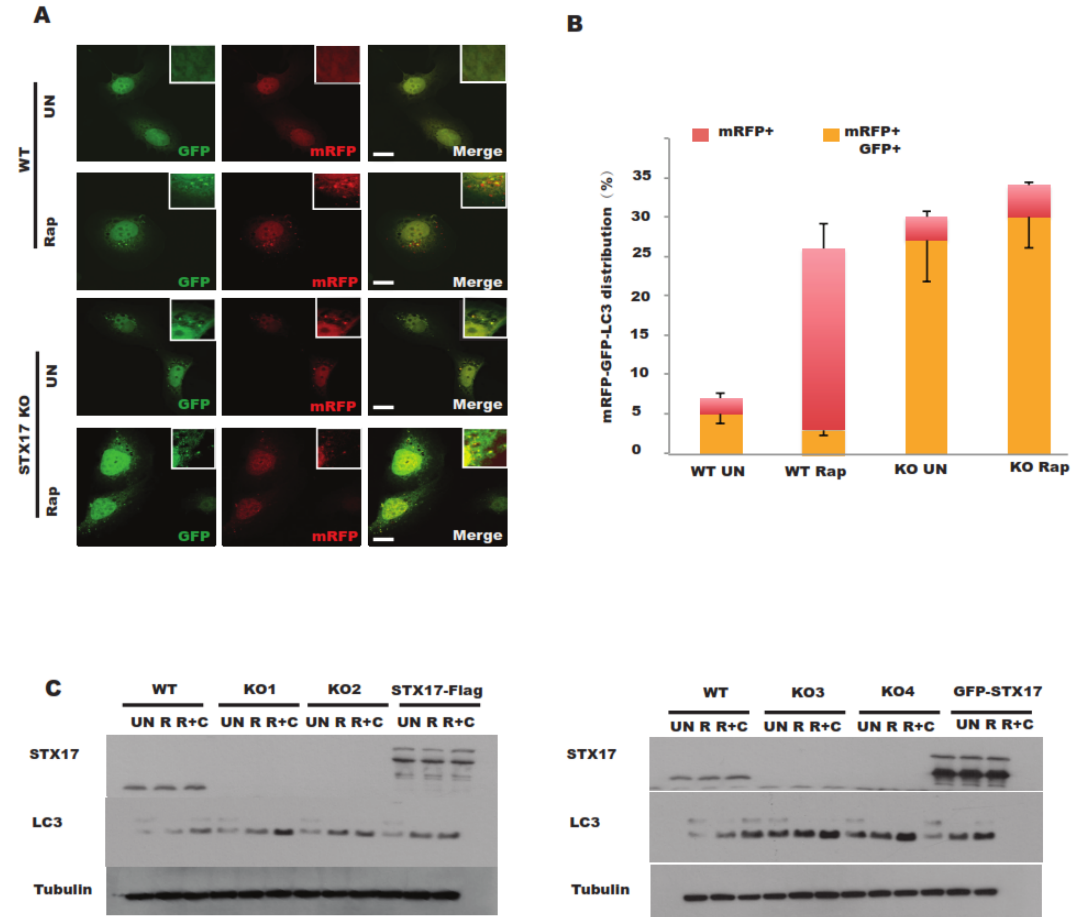
Figure 2. Autophagy flux is partially blocked in STX17 knockout U 2 OS cells. ( A ) WT and STX17 KO U2OS cells were transfected with monomer red fluorescent protein (mRFP)–GFP–LC3B. After 24 h, cells were treated with rapamycin before fixation and analyzed by confocal microscopy. Scale bar: 15 µ m. ( B ) Quantitative analysis of acidified autophagosomes (mRFP + GFP − ) versus neutral autophagosomes (mRFP + GFP + ). ( C ) Analysis of the autophagy flux in four STX17 knockout clones upon di ff erent treatments for immunoblotting analysis. R, Rapamycin. CQ, Chloroquine. RC, Rapamycin + Chloroquine.